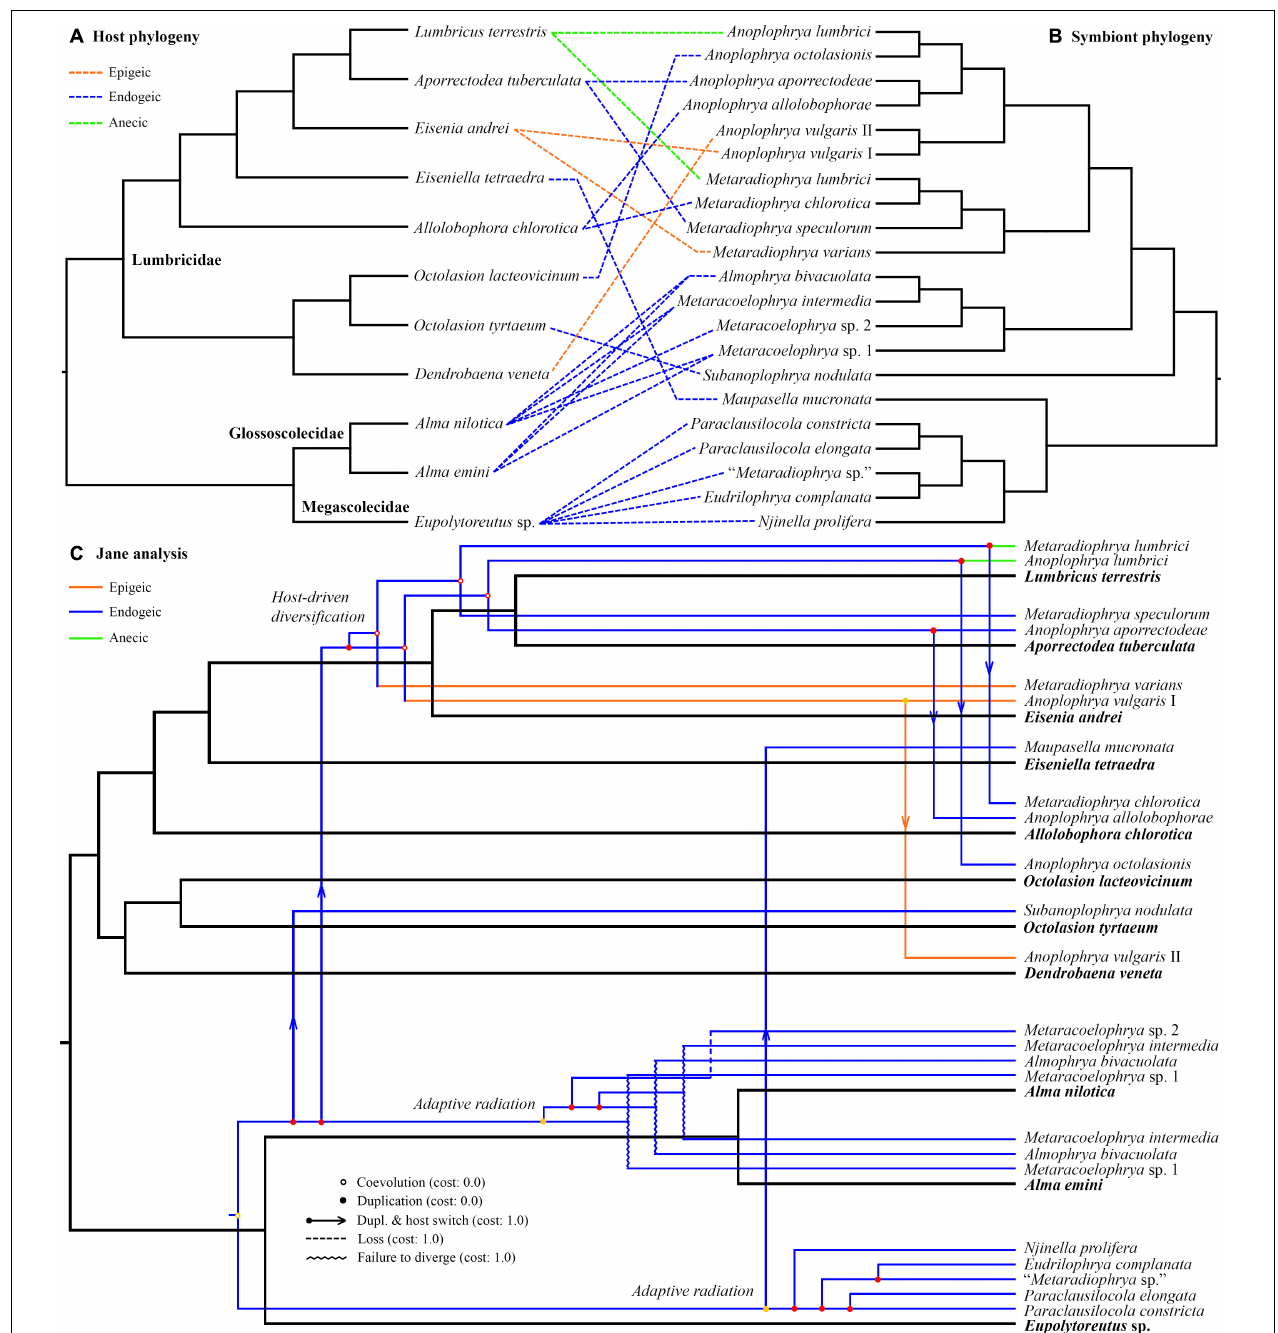
FIGURE 4 | (A,B) Tanglegram showing associations between earthworm hosts and their astome symbionts. (C) One of the most parsimonious cophylogenetic scenarios between earthworm hosts and their astome symbionts constructed with Jane under default settings. Black branches represent the host phylogeny, and colored branches represent the symbiont phylogeny. Color denotes the ecological group of